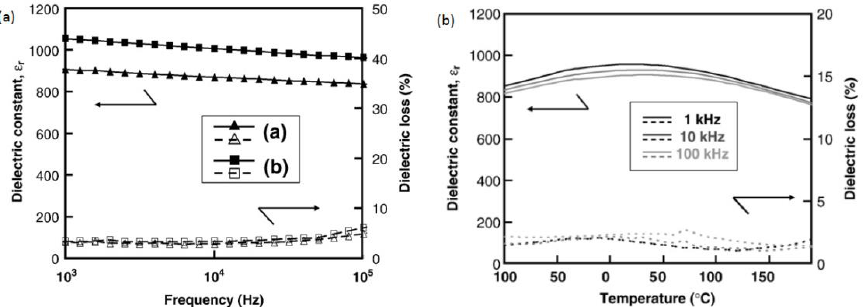
Figure 13. Dielectric constant and loss of (Ba,Ca)(Zr,Ti)O 3 thin films on Pt/TiOx/ SiO 2 /Si